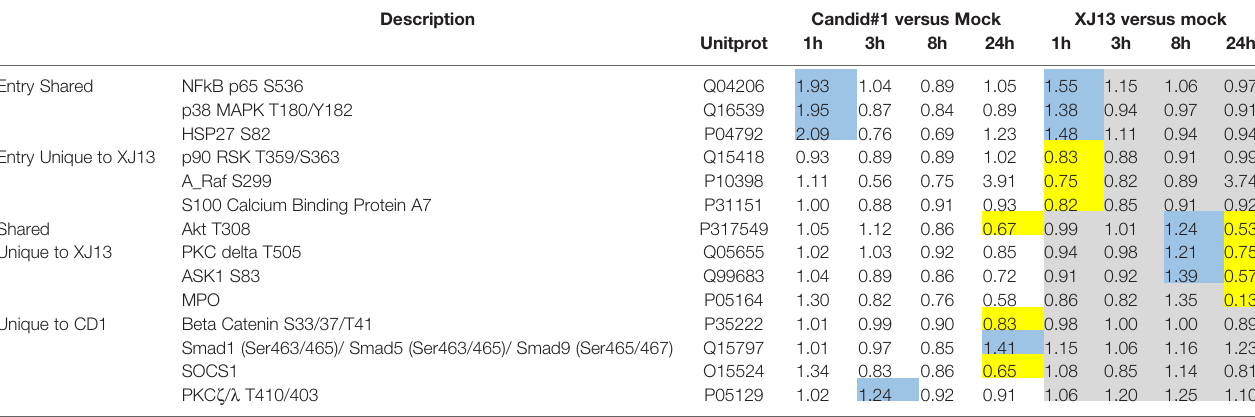
TABLE 1 | Signi fi cant changes in signaling protein phosphorylation following infection with JUNV.